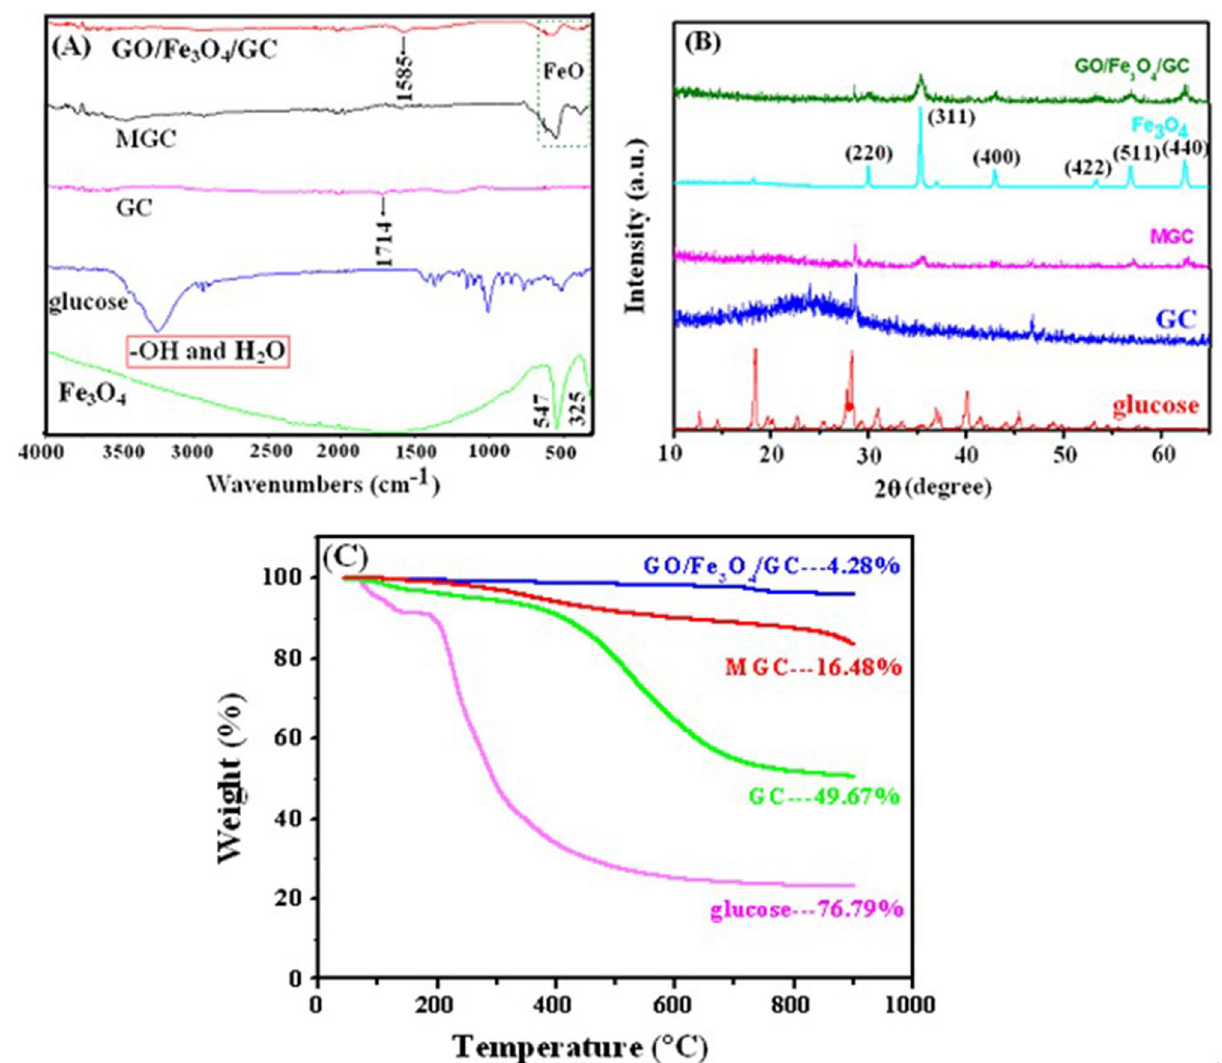
Figure 2. IR spectra ( A ), XRD patterns ( B ) and TGA curves ( C ) of the The element composition of Fe 3 O 4 , glucose, GC, MGC and GO/Fe 3 O 4 /GC was investigated by X-ray pho- toelectron spectrometer (XPS). The XPS survey spectrum of GO/Fe 3 O 4 /GC (Fig. 3A) shows that the evident characteristic peaks at about 285, 554, 711 and 725 eV attributed to C1 s , O1 s and Fe2 p , respectively. In the high- resolution spectrum of Fe 2 p (Fig. 3B), the peaks of Fe 2 p 3/2 and Fe 2 p 1/2 are located at 711.30 eV and 724.70 eV, respectively, indicating the presence of Fe 3 O 4 in the composite GO/Fe 3 O 4 /GC. Based on the above characterization results, a possible formation mechanism for GO/Fe 3 O 4 /GC is illustrated in Fig. 4. Firstly, GO nanosheet is physically mixed with GC in an ultrasonic bath to form the complex GO · GC through hydrogen bond interaction as shown in Eq. (1). Then, Fe n+ (n = 2, 3) ions were formed in the above suspension by adding Fe 2+ ions because a part of Fe 2+ ions were oxidized to Fe 3+ in air by the redox reaction as shown in Eq. (2). With the hydrolysis of Fe 3+ and the addition of 30% ammonia solution the magnetic composite GO/Fe 3 O 4 /GC was obtained as expressed in Eqs. (3) and (4). Thus, both GC and Fe 3 O 4 are immobilized on the surface of GO.